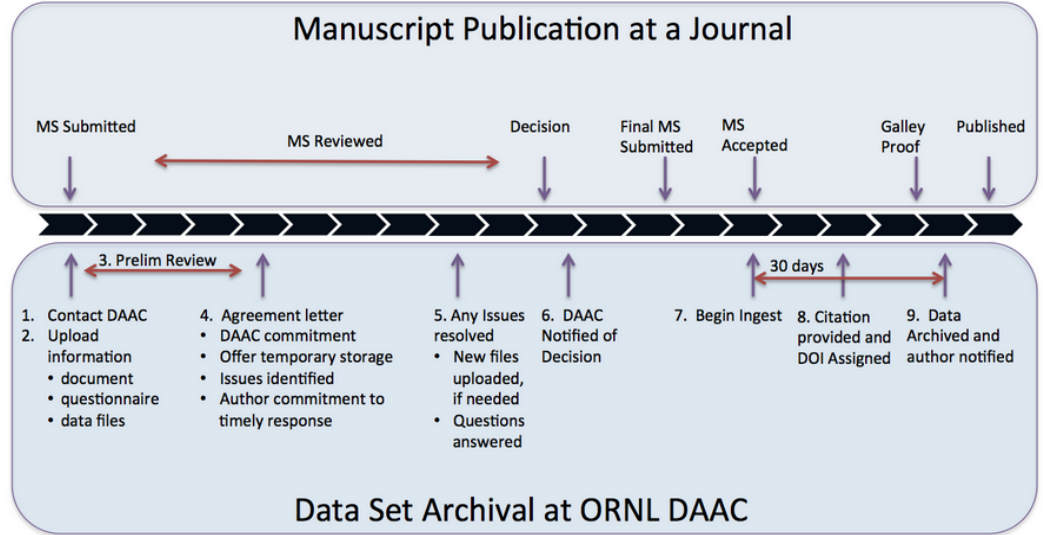
Figure 10. Time-line for archiving data associated with a manuscript. Data products used in a manuscript are submitted to the ORNL DAAC at the same time as the manuscript is submitted to the journal. An agreement is reached between the DAAC and the authors, with the author agreeing to respond to queries in a timely manner, and the ORNL DAAC agreeing to archive the data and provide a citation and persistent DOI close to the time of article publication.